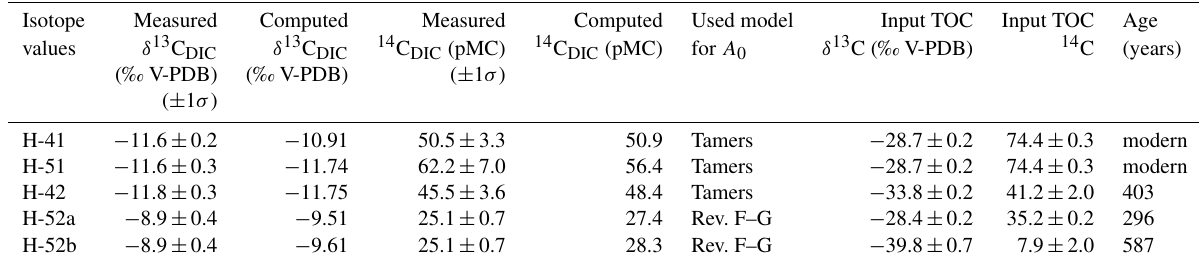
Table 4. Measured and NETPATH-computed isotopic data. Isotope Measured Computed Measured Computed Used model Input TOC Input TOC Age values δ 13 C DIC δ 13 C DIC 14 C DIC (pMC) 14 C DIC (pMC) for A 0 δ 13 C (‰ V-PDB) 14 C (years) (‰ V-PDB) (‰ V-PDB)